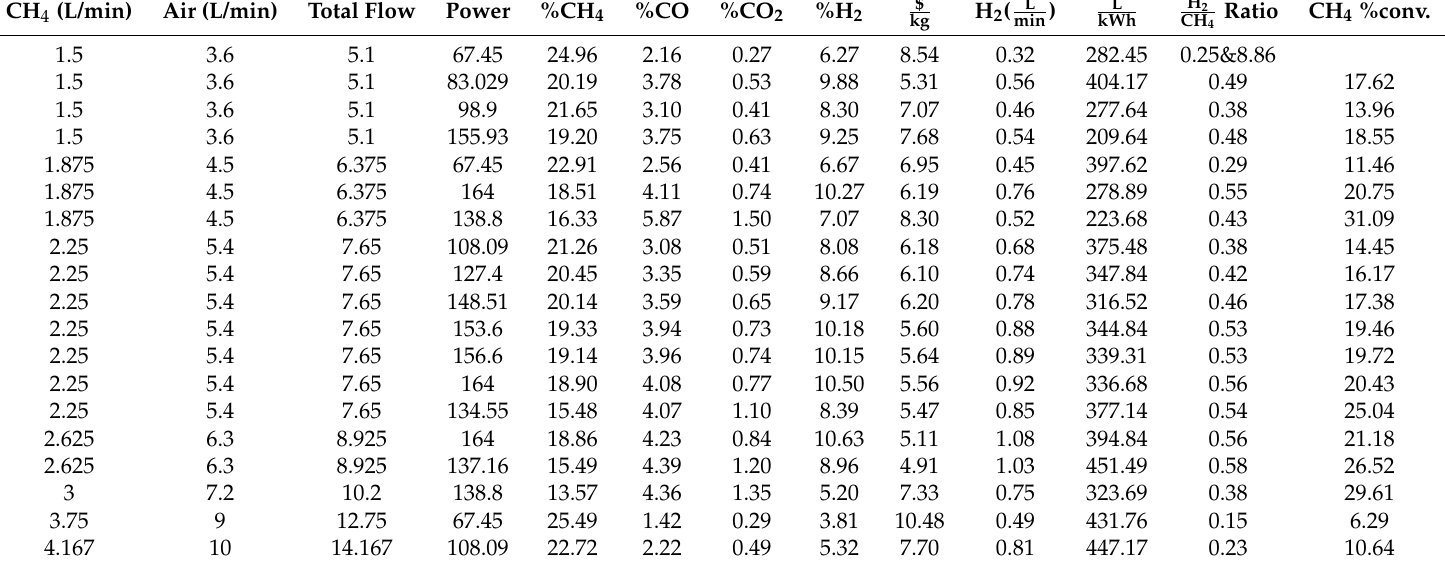
Table 2. Experimental results—constant flow rate ratio of 2.4:1, where price per ccf of methane psia = $0.366 and Price per kWh of electricity =